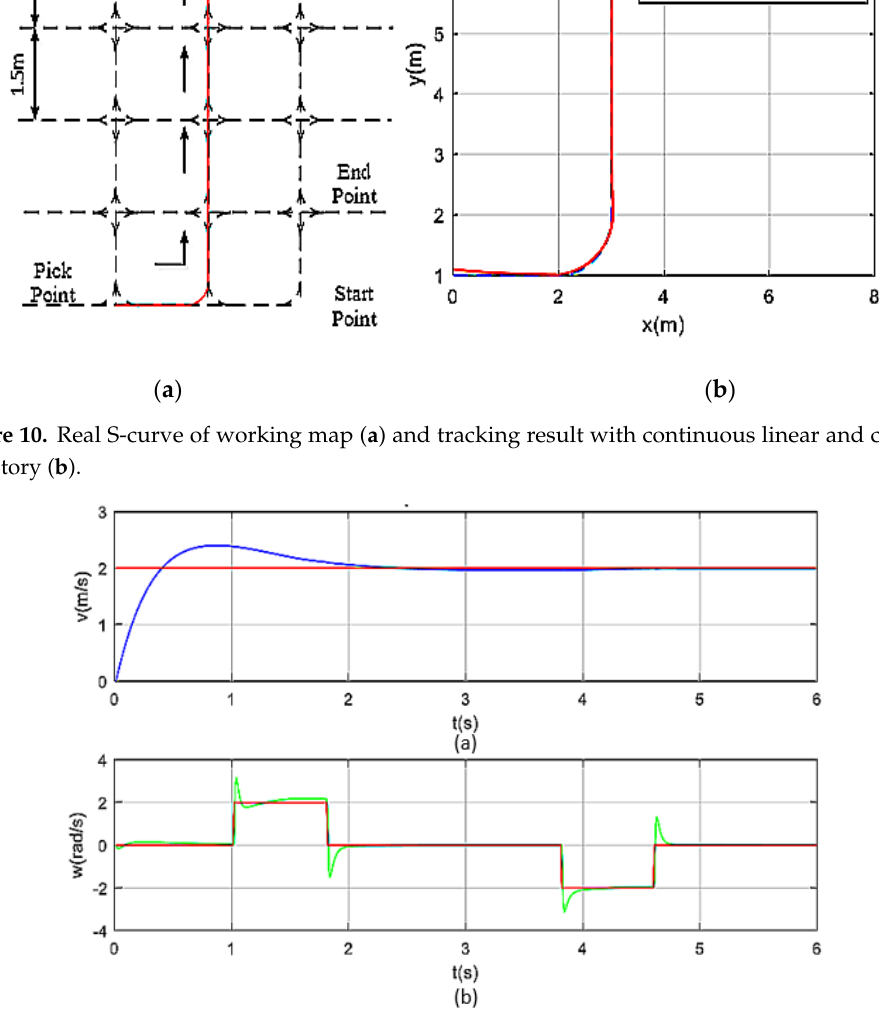
Figure 11. Performance of linear velocity ( a ) and angular velocity ( b ) in tracking S-curve of working map.